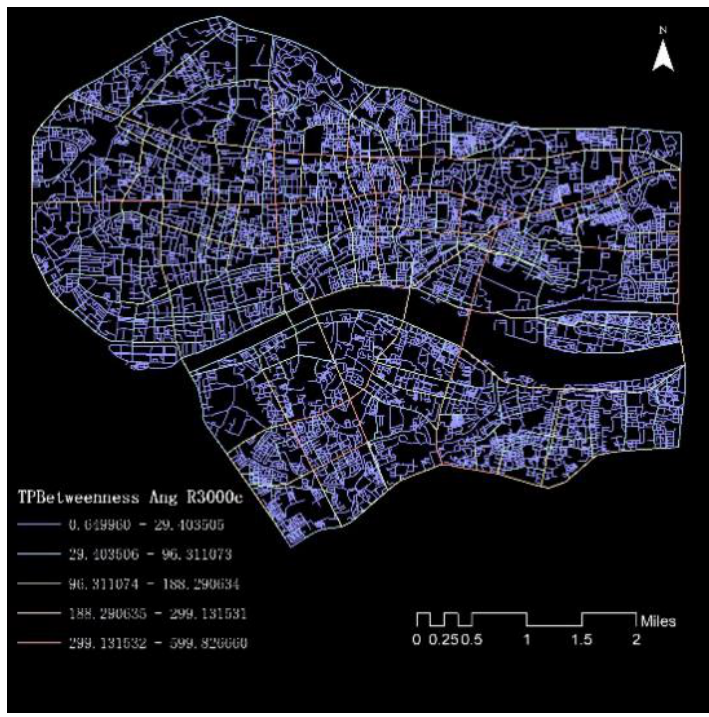
Fig. 19 Regional TPBt at a radius of 3000m